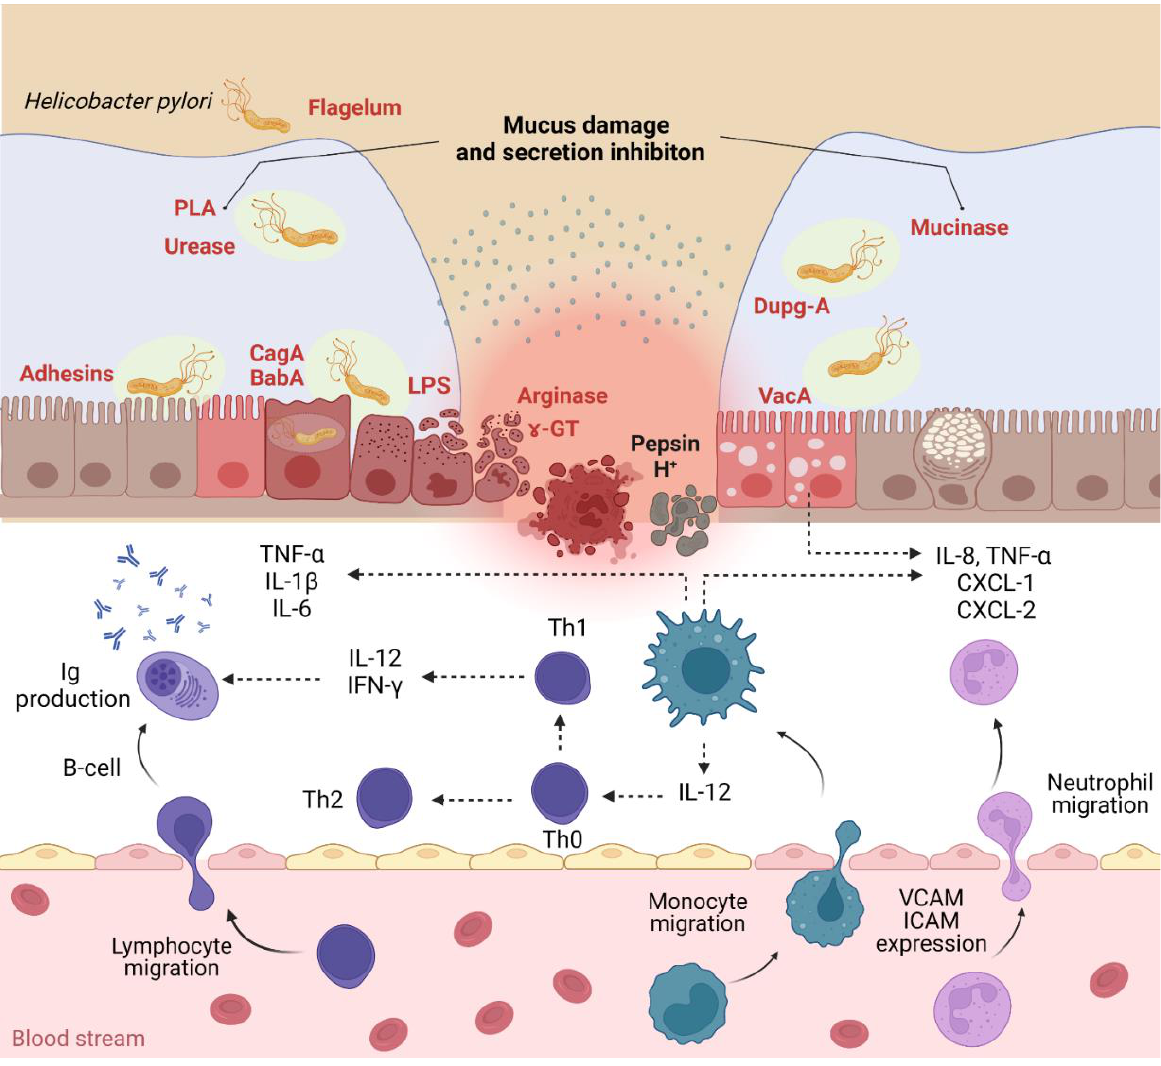
Figure 1. H. pylori infection pathogenicity and inflammatory response (PLA—phospholipases; Dupg—duodenal ulcer-promoting gene A; CagA—cytotoxin-associated gene A; BabA—blood group antigen-binding adhesin; VacA—vacuolating cytotoxin A; CXCL—chemokine ligand; VCAM—vascular cell adhesion molecules; ICAM—intercellular cell adhesion molecules). Created using BioRender (adapted from